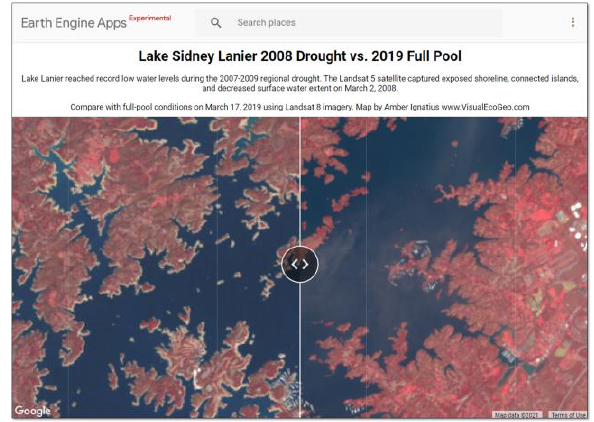
Figure 4. Google Earth Engine map application for Landsat 5 and Landsat 8 drought assessment of Lake Sidney